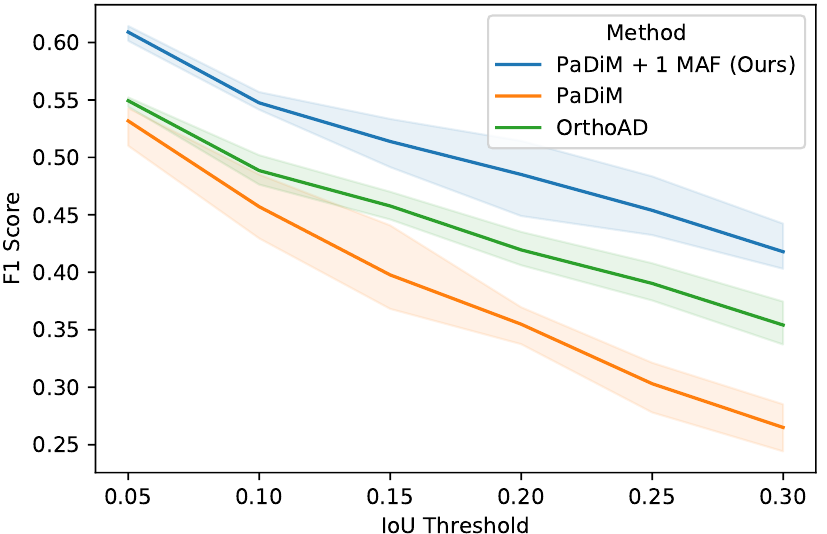
Figure 8. F1 score on the Semmacape dataset with different IoU thresholds. The mean performance and 95% confidence interval is reported over 3